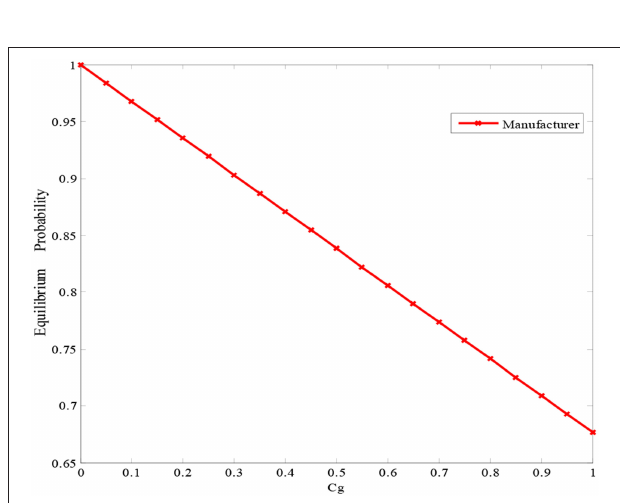
FIGURE 7 | The manufacturer’s equilibrium probability as a function of C g .